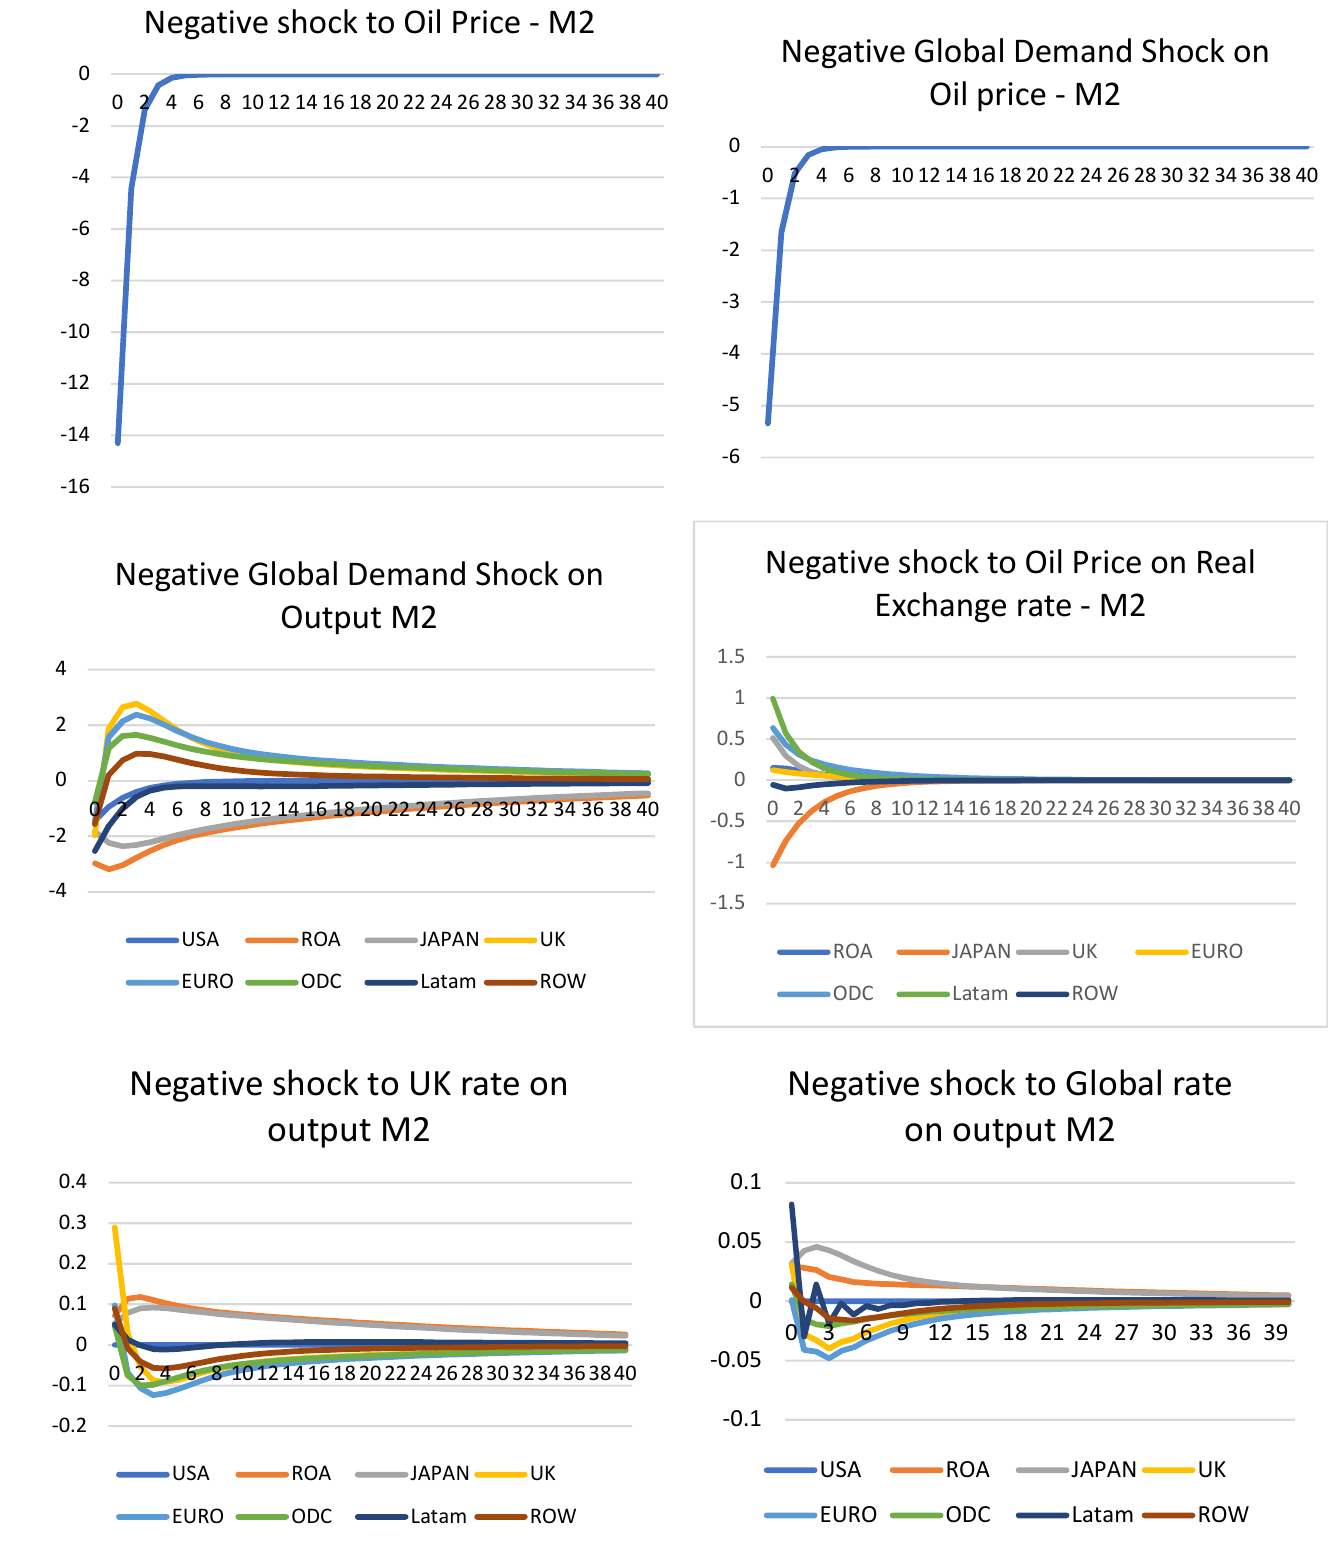
Figure 7. Additional negative shocks to M2.